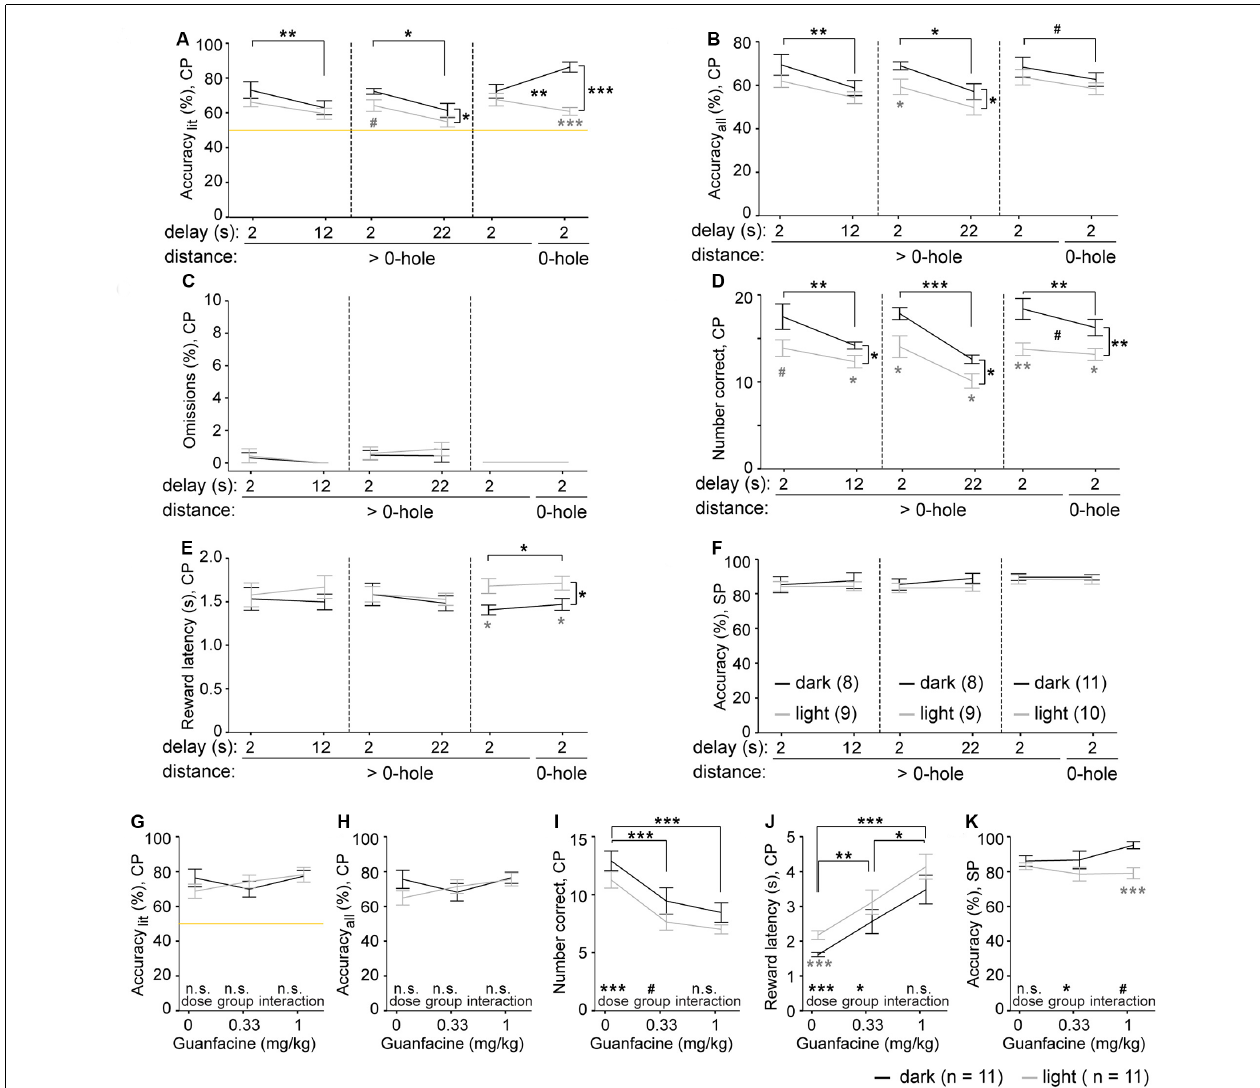
FIGURE 2 | Effects of challenges and guanfacine on 5-CSWM performance. (A–F) Performance parameters for three distinct challenge paradigms and their individual baseline (averages of two sessions in each case), including an extension of the delay from 2 s to 12 s (left) and 22 s (middle), and the use of choice options that were always directly neighboring holes (right) instead of having 1–2 non-illuminated holes in between them. Parameters indicate SWM according to accuracy lit (A) and accuracy all (B) , calculated as in Figure 1 , the relative number of CP omissions (normalized to number of CPs, C ), the absolute number of correct CP responses (D) , the CP reward latency as control variable for motivation (E) , and the accuracy with which the illuminated hole was chosen in the SP as control variable for cue-directed attention (F) . Black significance indicators refer to repeated-measures ANOVA, effects of group displayed on vertical lines, effects of challenge on horizontal lines, interactions indicated between data-lines; gray stars indicate simple main-effects post hoc comparison between groups at individual conditions. N -numbers for groups trained in the dark (black) and light (gray) protocol are indicated in panel (F) . (G–K) Performance parameters for SWM, accuracy lit (G) and accuracy all (H) , as well as number of correct CP responses (I) , the CP reward latency as control variable for motivation (J) , and the accuracy with which the illuminated hole was chosen in the SP as control variable for cue-directed attention (K) are plotted for the groups tested in the dark (black) and light (gray) protocol after guanfacine pre-treatment at the indicated doses (n-numbers stated in legend underneath respective panels; 2 s SP-SD, 12 s delay). For clarity, statistical effects of drug-dose, group and interactions found in repeated-measures ANOVA are indicated above the respective words in each panel, while simple main-effects paired dose-comparisons are indicated on horizontal lines (black) and pairwise comparison between groups at individual doses are indicated below the data points (gray). n.s. or no indication p > 0.1, # p < 0.1, ∗ p < 0.05; ∗∗ p < 0.01; ∗∗∗ p < 0.001. All data is shown as mean ± SEM.